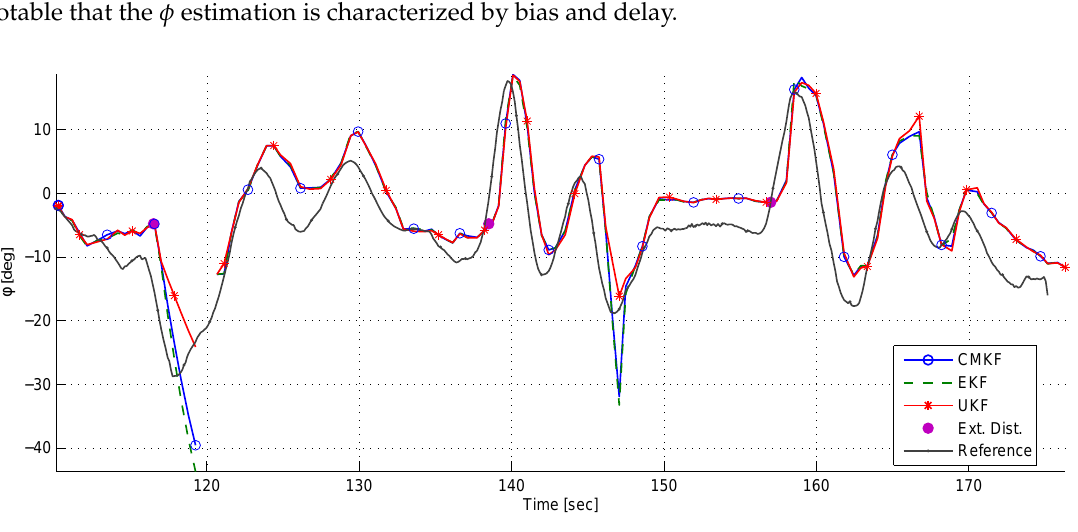
Figure 17. A comparison of the azimuth estimates using different filters in the semi-static